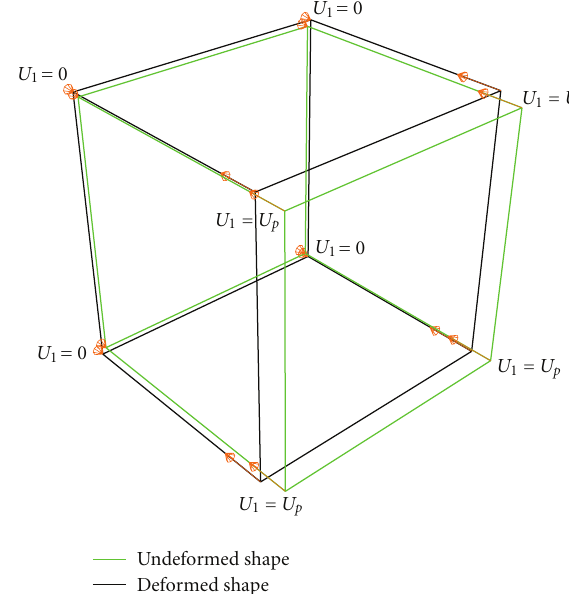
(13) Stress transformation from the material(local) to the element coordinate system (global)